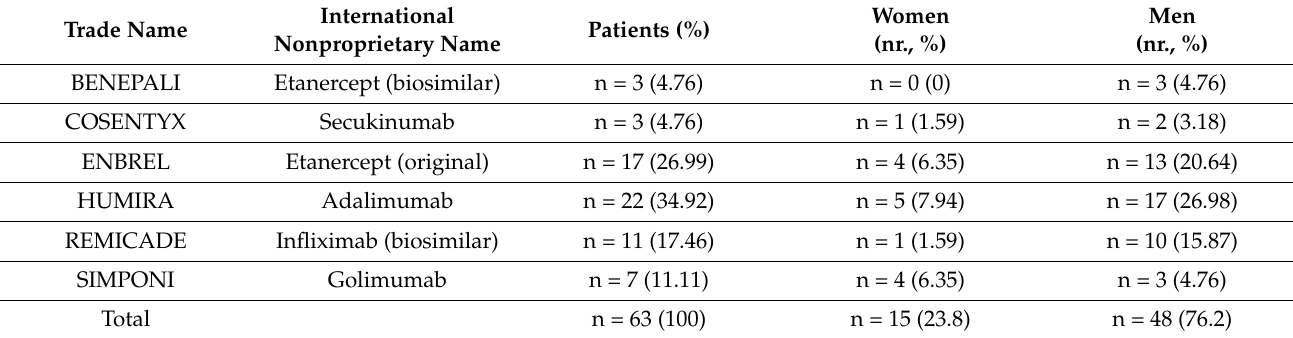
Table 5. Distribution of AS patients by gender and the biological therapy followed at the time of inclusion in the